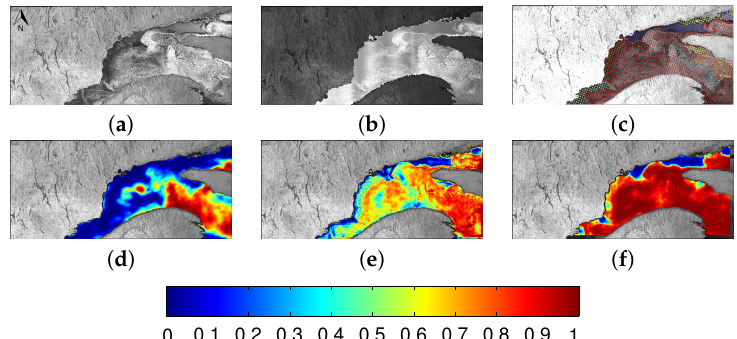
Figure 5. Ice concentration estimated by CNN compared to that from other methods. The HH and HV images are shown in panels ( a ) and ( b ) respectively. Panel ( c ) is the image analysis. Panels ( d – f ) are ice concentration from ASI, MLP40 and CNN respectively. Scene shown is 20140210_103911, which is used for testing. Scene centered at 49.90 ◦ N, 66.42 ◦ W with extent of 500 km by 230 km.